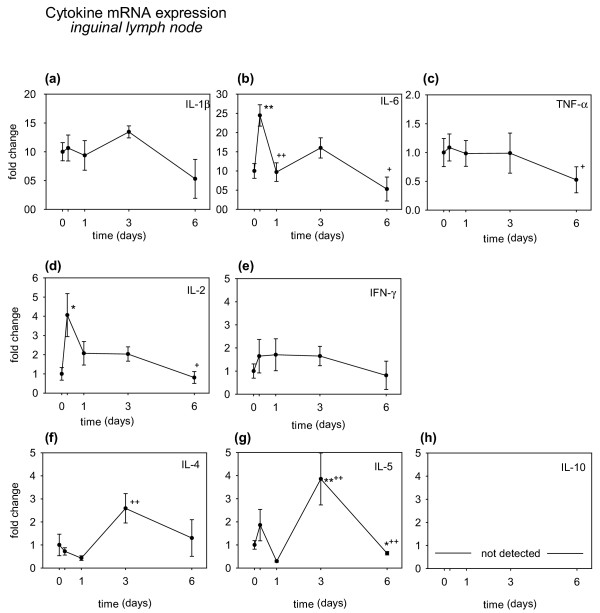
Expression of mRNA for various cytokines in the inguinal lymph nodes of rats with AIA. Time course and other details as in Fig. 2. AIA, antigen-induced arthritis.